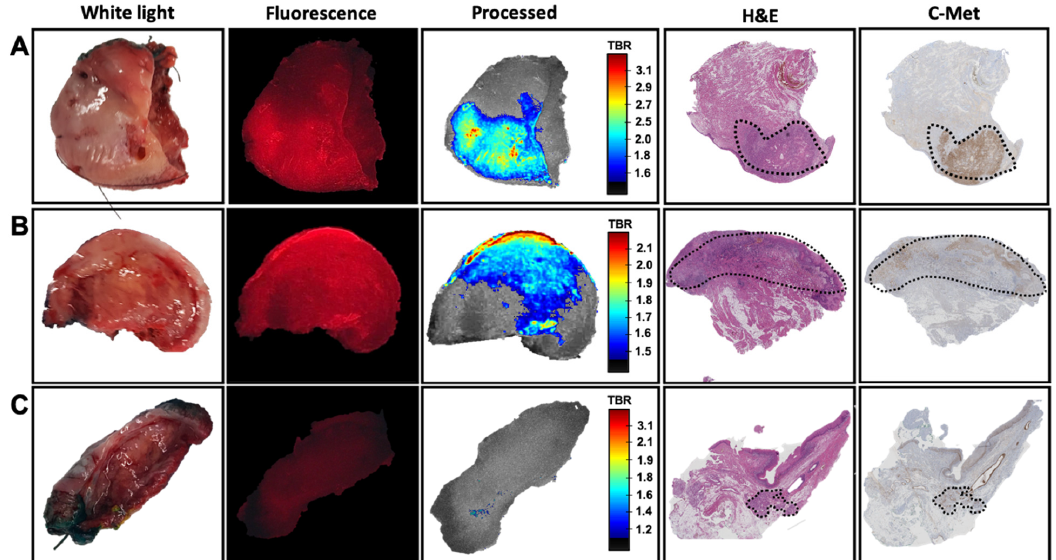
Figure 3. The correlation between c-Met targeted fluorescence and immunohistochemistry. Overview of imaging and pathological assessment of three different samples showing ex vivo white light, Cy5-based fluorescence imaging of the incubated tissue (fluorescence in red), real-time image processing of the fluorescence signal (including video representation of tumor-to-background ratio (TBR)), H&E staining and c-MET immunohistochemistry. ( A ) superficial tumor localization, ( B ) tumor presence on the cleavage plane and ( C ) a sample without tumor presence on the cleavage plane. Delineation of the tumor (dashed) was based on H&E.